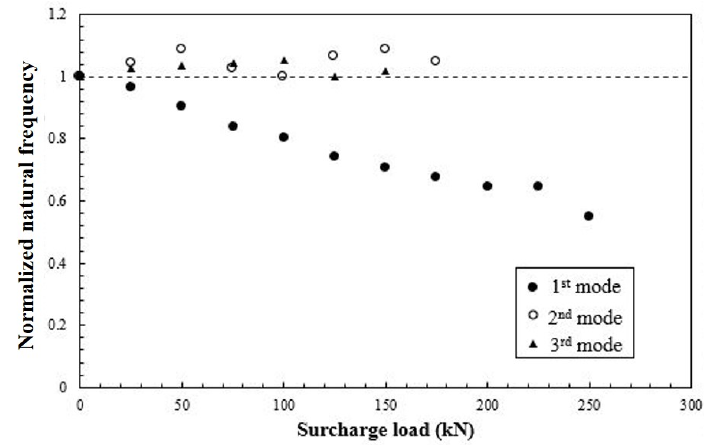
Figure 15. Normalized natural frequency according to the surcharge load (first, second, and third modes).